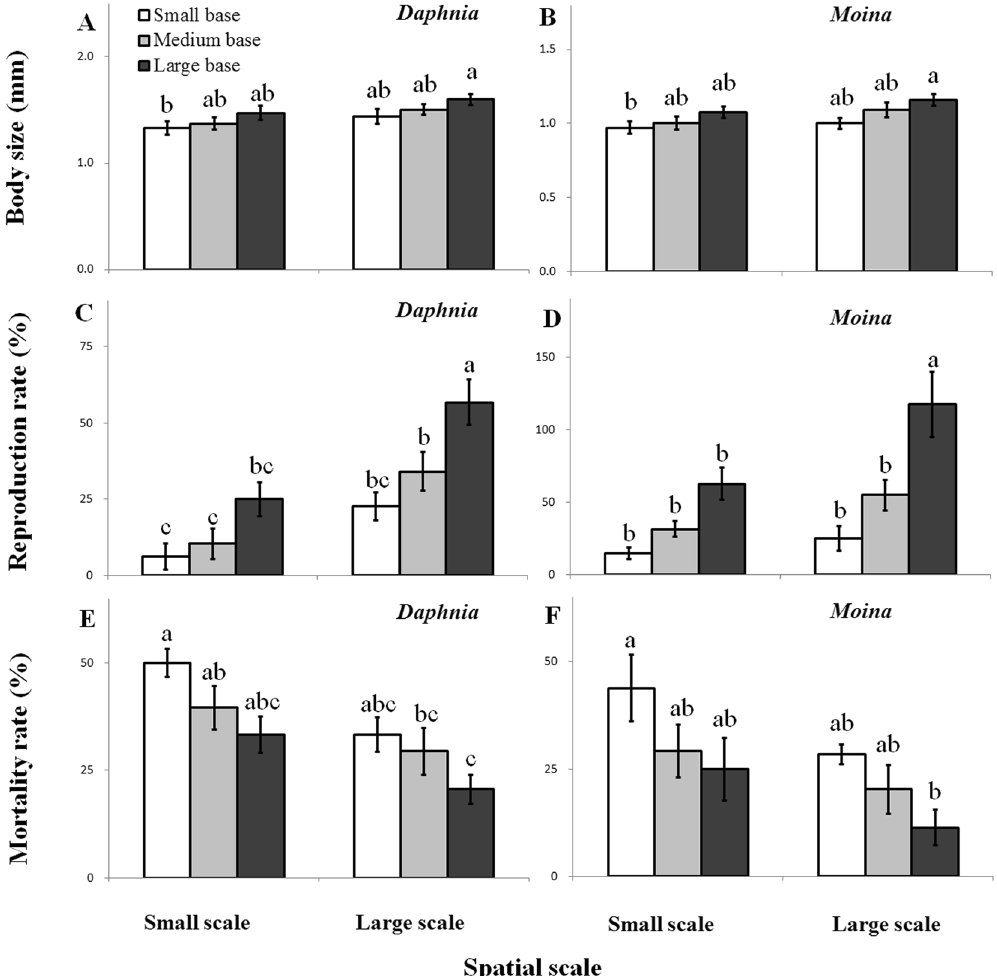
Figure 3. Variations (means ± 1 s.d., n = 6) in body size ( A , B ), reproduction rate ( C , D ) and mortality rate ( E , F ) of grazer species ( Daphnia magna and Moina micrura ) under three levels of habitat orientation and two levels of spatial scale. Different letters indicate significant differences among treatments. Multiple comparisons of means were performed using Tukey’s test at the 0.05 significance level. Figure 3 was created using Microsoft Excel